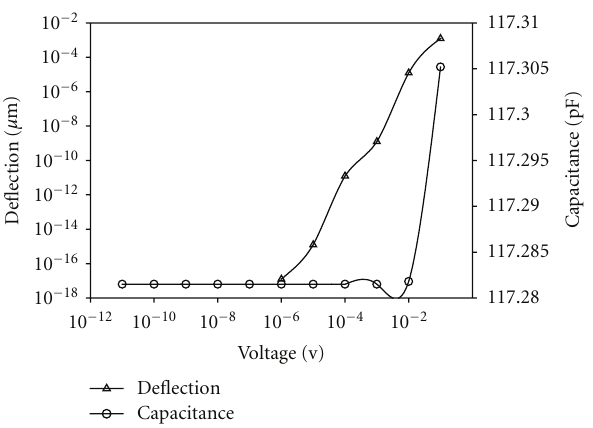
Figure 14: Average gap percentage increment for di ff erent electrode